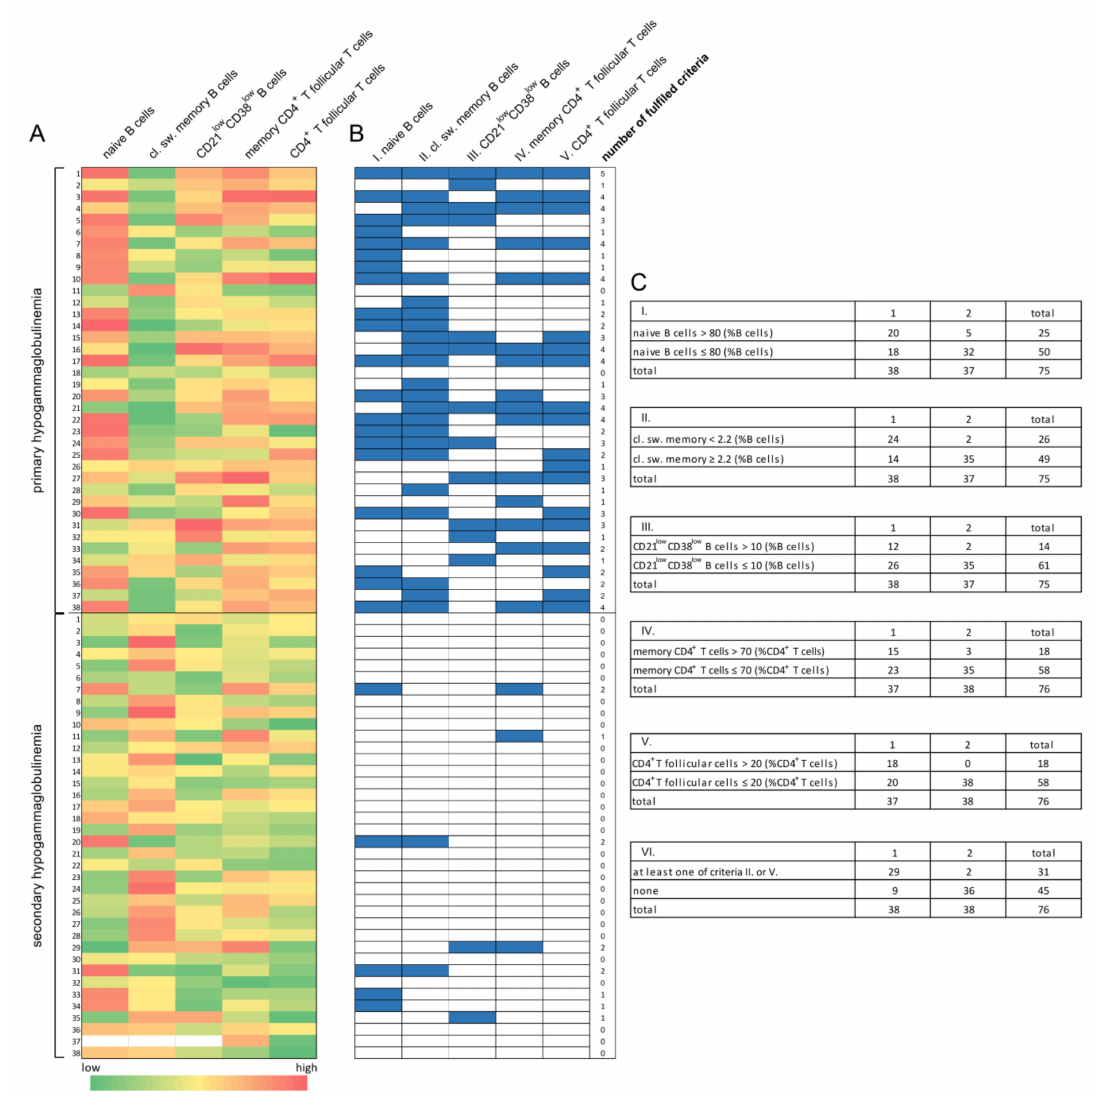
Figure4. Diagnosticcriteriafordistinguishingprimaryfromsecondaryhypogammaglobulinemiabased in the di ff erential B and T cell subset distribution in patients with primary immunodeficiency disorders (PID) as compared to patients with rheumatic disease and secondary hypogammaglobulinemia. ( A ) Heat map showing percentages of B and T cell subsets in all studied patients and highlighting their di ff erential distribution. ( B ) Schematic representation of fulfilled diagnostic criteria (marked with blue) discriminating PID from secondary hypogammaglobulinemia. ( C ) Proposed diagnostic criteria for distinguishing primary from secondary hypogammaglobulinemia and cross tables showing all studied patients fulfilling or not fulfilling each time indicated